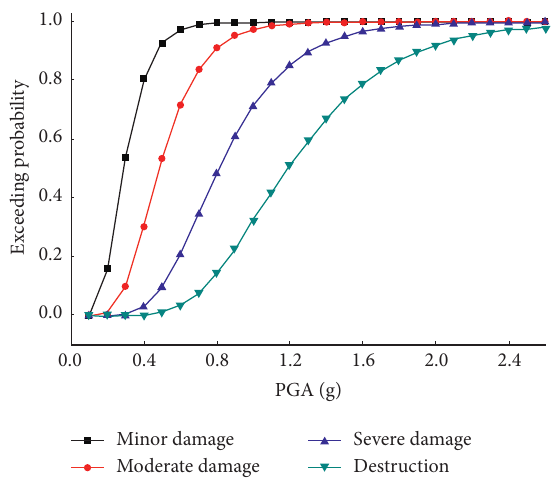
Figure 10: Embankment seismic fragility curves. Table 7: Exceeding probabilities of each embankment seismic damage grade under different PGAs. Embankment seismic damage grades